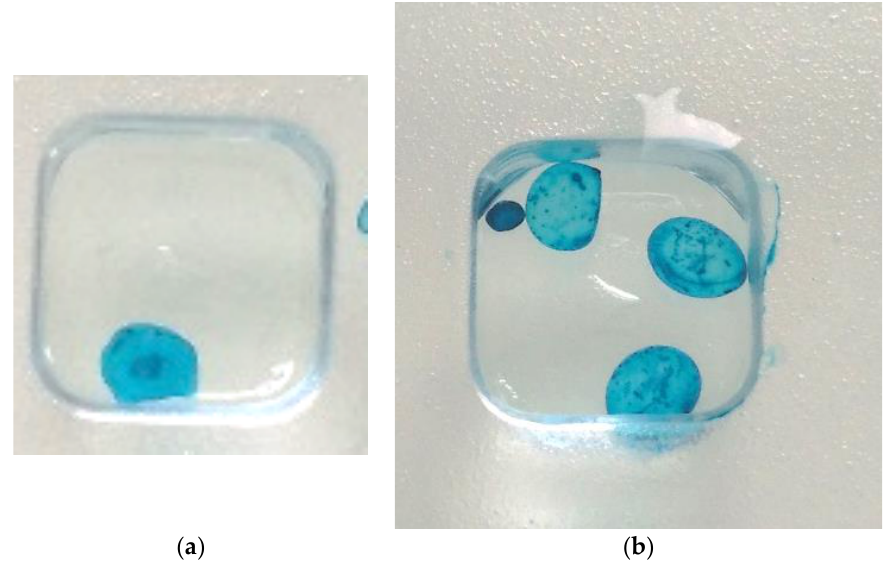
Figure A6. Picture of alcian blue stained beads ( a ) immediately after obtention (darker spot in the middle was due to drying of the bead, which was exposed to ambient air for too long); ( b ) after 21 days of culture. Darker blue spots indicate presence of glycosaminoglycan.